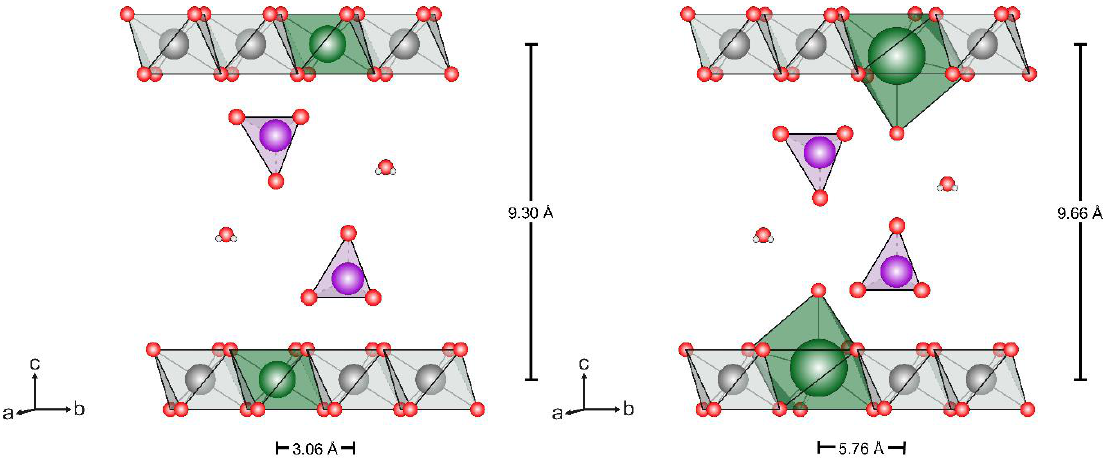
Figure 1. Schematic illustration of the structure of a permanganate intercalated hydrotalcite ( left ) and hydrocalumite ( right ). Magnesium and calcium are shown as green, aluminium as grey, oxygen as red, and manganese as purple balls. For better clarity, the hydrogen atoms are not shown. Structural data based on Allman and Jepsen [23] and Mills et al. [20].